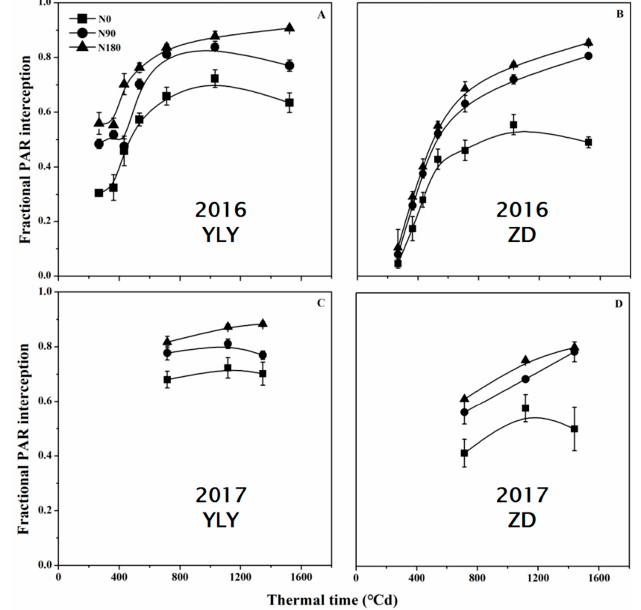
Figure 4. Fractional PAR interception ( f ) of YLY ( A,C ) and ZD ( B,D ) as a function of thermal time under different N treatments in 2016 ( A,B ) and 2017 ( C,D ). Vertical bars represent S.D. of the mean (n = 3) where these exceed the size of the symbol.